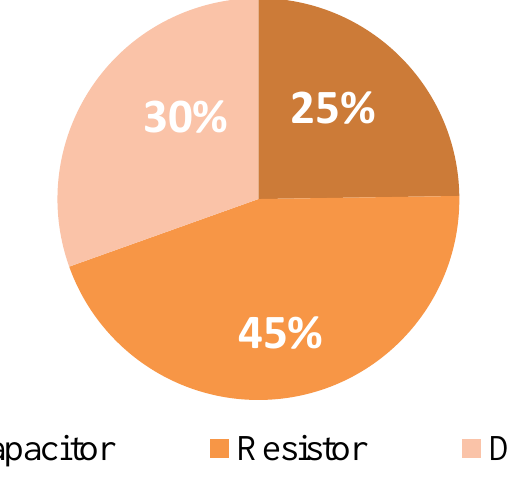
Figure 2. Distribution of dataset class data.